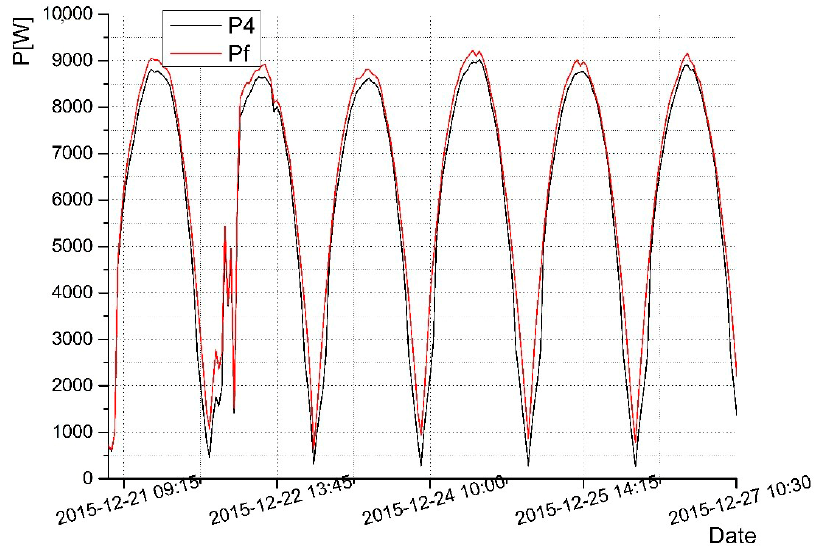
( b ) Figure 8. Comparison between the actual power output and simulated values for different seasons of the year 2015: (a) in July and (b) in October–November. The fault causes significant deviation, especially in midday, when the levels of irra- diance are higher and, respectively, temperature values. The temperature behavior of a faulty PV panel may affect the DC voltage of the string in which it is connected. Significant deviation in DC voltage may affect MPP tracker operation and consequently power out- put in these conditions. This type of fault also has significant impact on the statistical met- rics, which allows it to be reliably quantified. Values of 10–20% in nRMSE are observed,